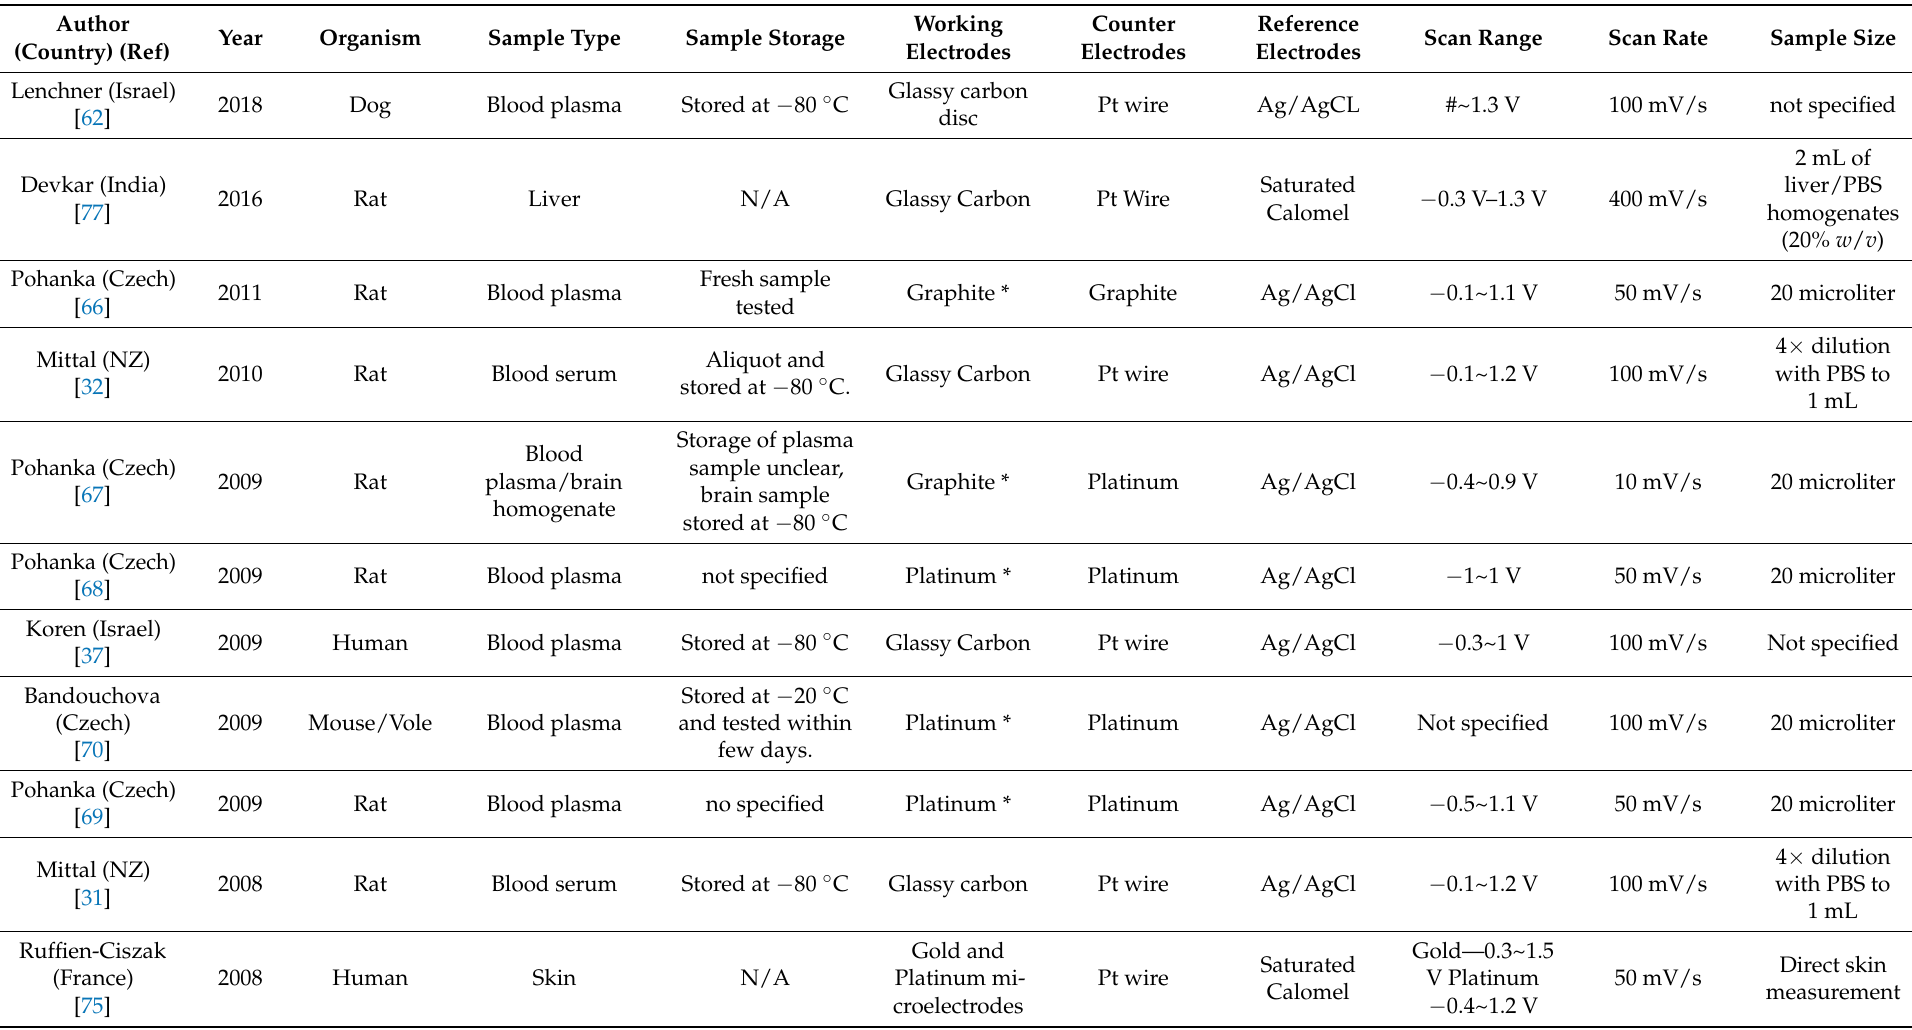
Table 1. Summary of studies with published information on organisms, sample type and voltammetry technique